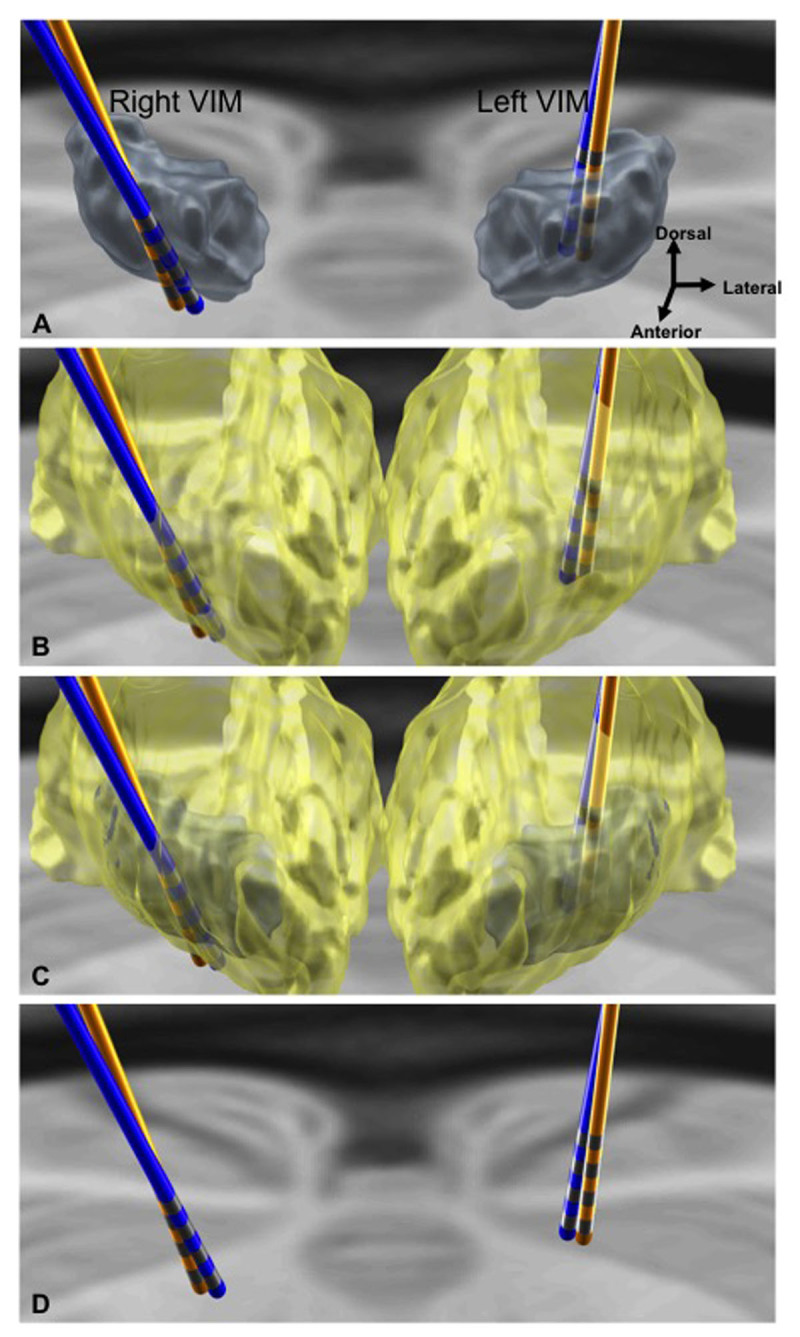
3D rendering of bilateral DBS VIM electrodes, initial vs. current. Sections A–C depict bilateral VIM leads in relation to targeted grey structure of VIM proper (A), yellow structure of thalamus (B), and overlay of VIM within the thalamus (C). Section D shows relative lateral shift of current VIM electrodes. The original DBS lead location is depicted in blue, and current DBS lead location in orange. His current optimized DBS settings are: 2- C+1.7V PW 90 Freq 135 (left VIM), and 10- C+ 1.0V PW 90 Freq 135 (right VIM).